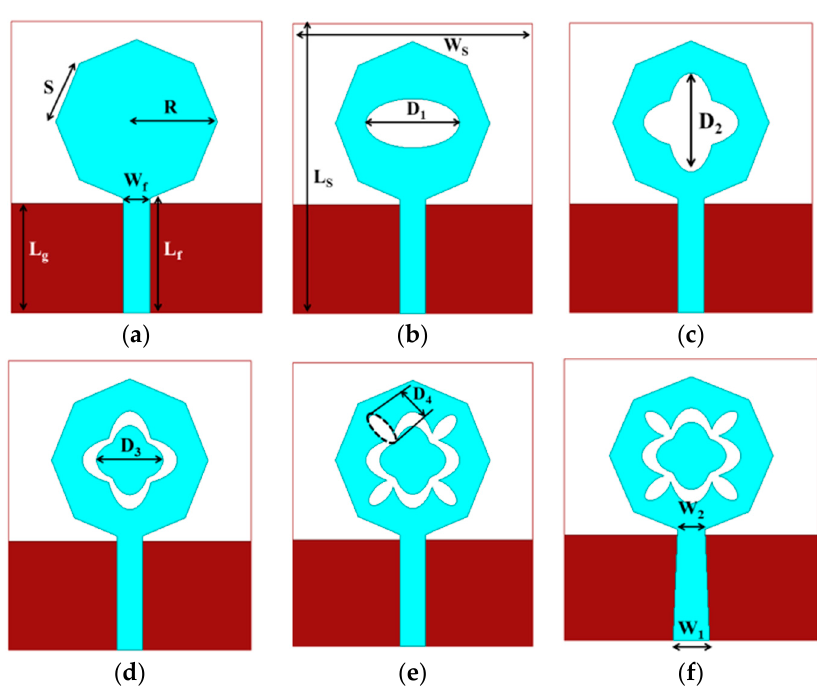
Figure 2. Geometry of SWB antenna with different design evaluations ( a ) iteration 1, ( b ) iteration 2, ( c ) iteration 3, ( d ) iteration 4, ( e ) iteration 5, ( f ) iteration 6. Evaluations of SWB Monopole Antenna